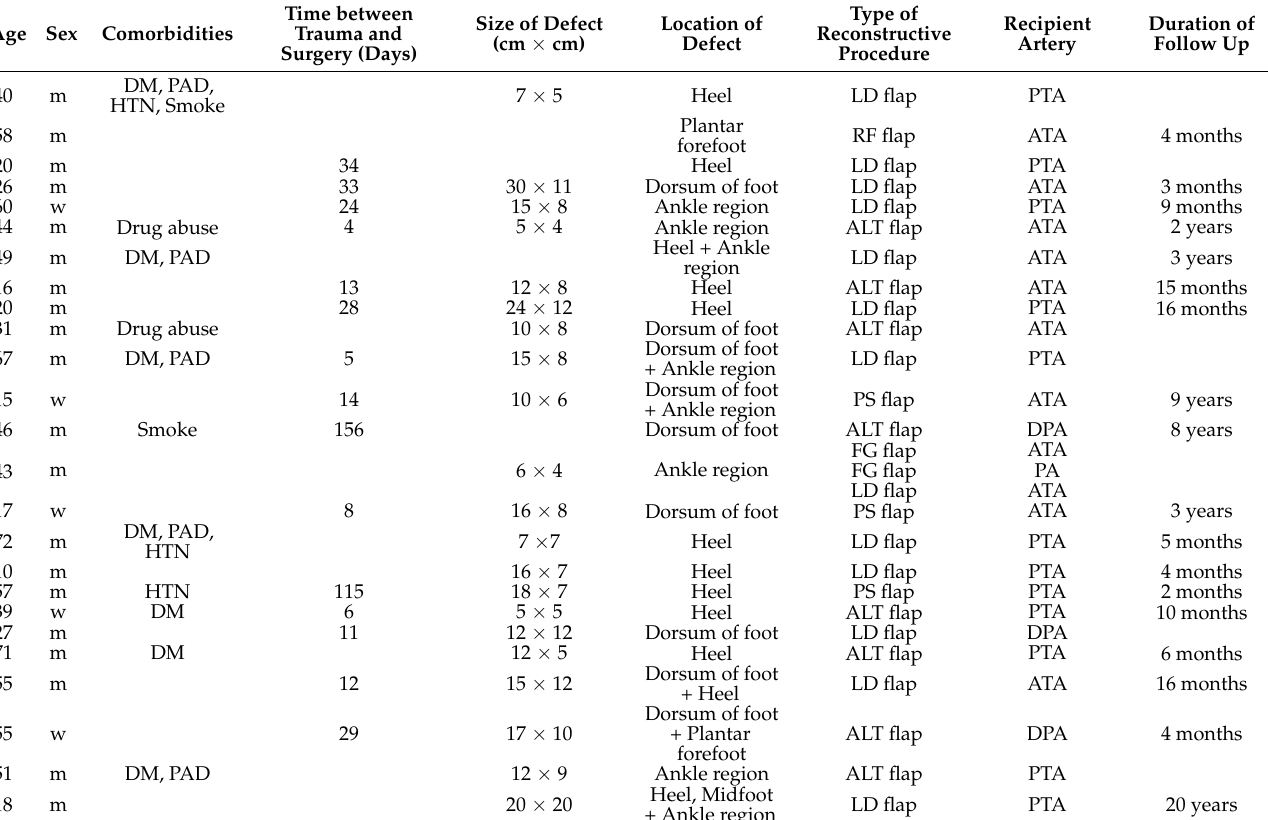
Table 1. Demographics, comorbidities, defect site, reconstructive procedure, and follow-up.